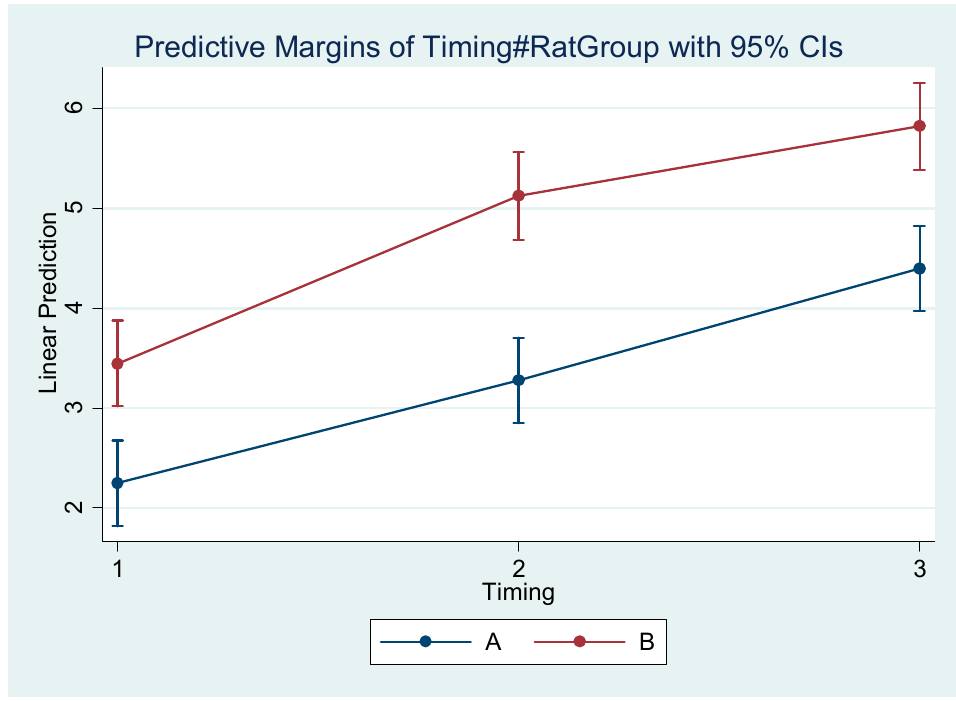
Figure 6. Estimated mean difference (Final–Initial) and 95% Confidence Interval per group and timing in Condylion–I’ (mandibular length).